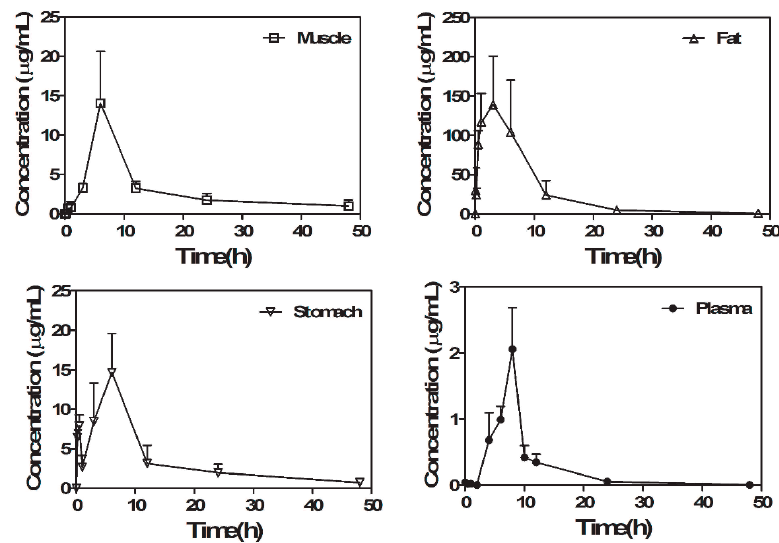
Figure 6. Concentration-time curves of RUS in rats tissues after oral administration ( n = 6).